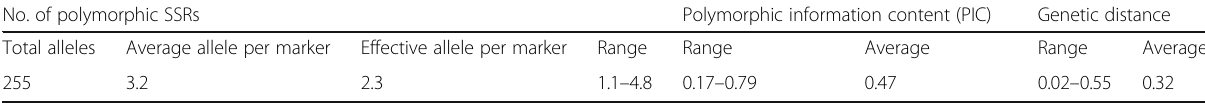
Table 1 Summary of SSR polymorphisms No. of polymorphic SSRs Polymorphic information content